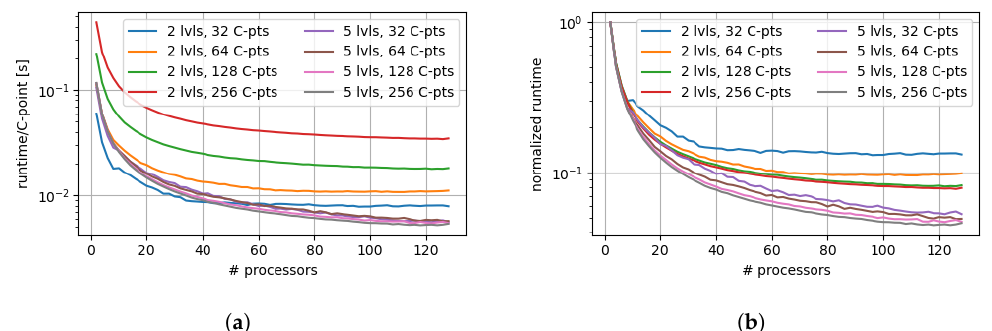
Figure 7. Multi-level allows for higher rates of parallelism, resulting in more speed-up in case the available resources are already exhausted by a two-level PinT algorithm. The plots illustrate this comparing speed-ups between the two-level and five-level versions of the MGRIT algorithm for 64, 96, 128, and 256 time-steps on the coarsest level. In all cases, a microgrid with four household- type elements was simulated with a coarsest time-step of ∆ t = 12.5 µ s and a fine time-step of δ t = 0.78125 µ s. For the five-level version, three intermediate coarsening levels with uniform coarsening factor cf = 2 were added, resulting in time-steps of ∆ t lvl = δ t runtime per coarse step. For all cases, the multi-level version scales better with increasing number of processors. ( b ) Illustration of speed-up only resulting from adding processors. Relative runtime compared to that of the first datapoint.